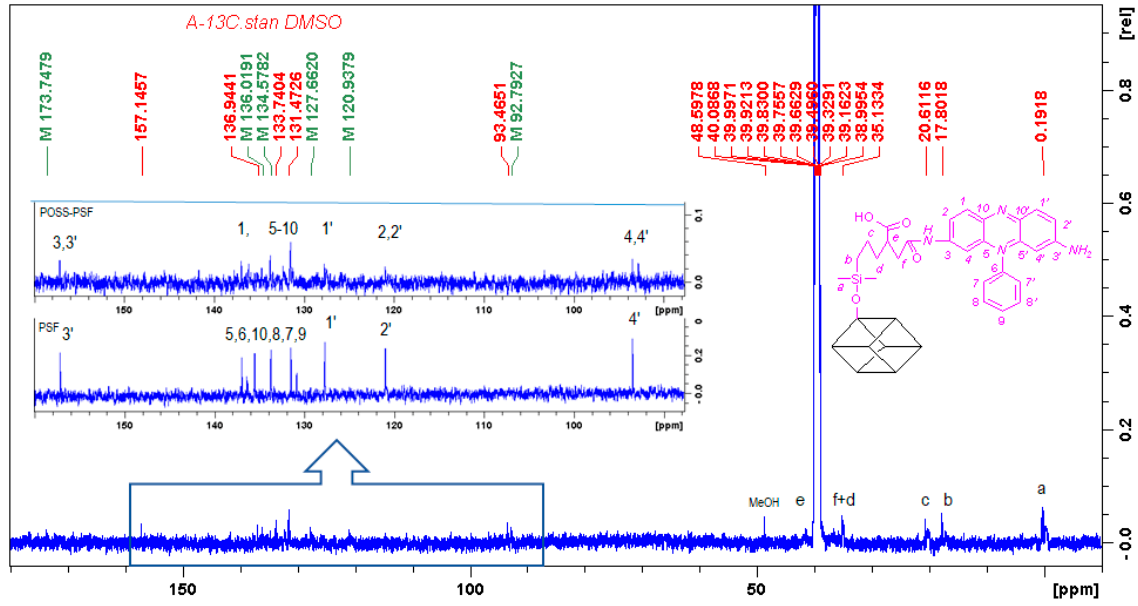
Figure 3. Comparison of the 13 C NMR (500 Hz) spectra of POSSPSF conjugate (bottom), expansion of the 160–85 ppm range (top) and PSF (in the middle) in DMSO- d6 . Table 1. 1 H, 13 C NMR shift assignment of PSF-photosensitizers in DMSO-d 6 .